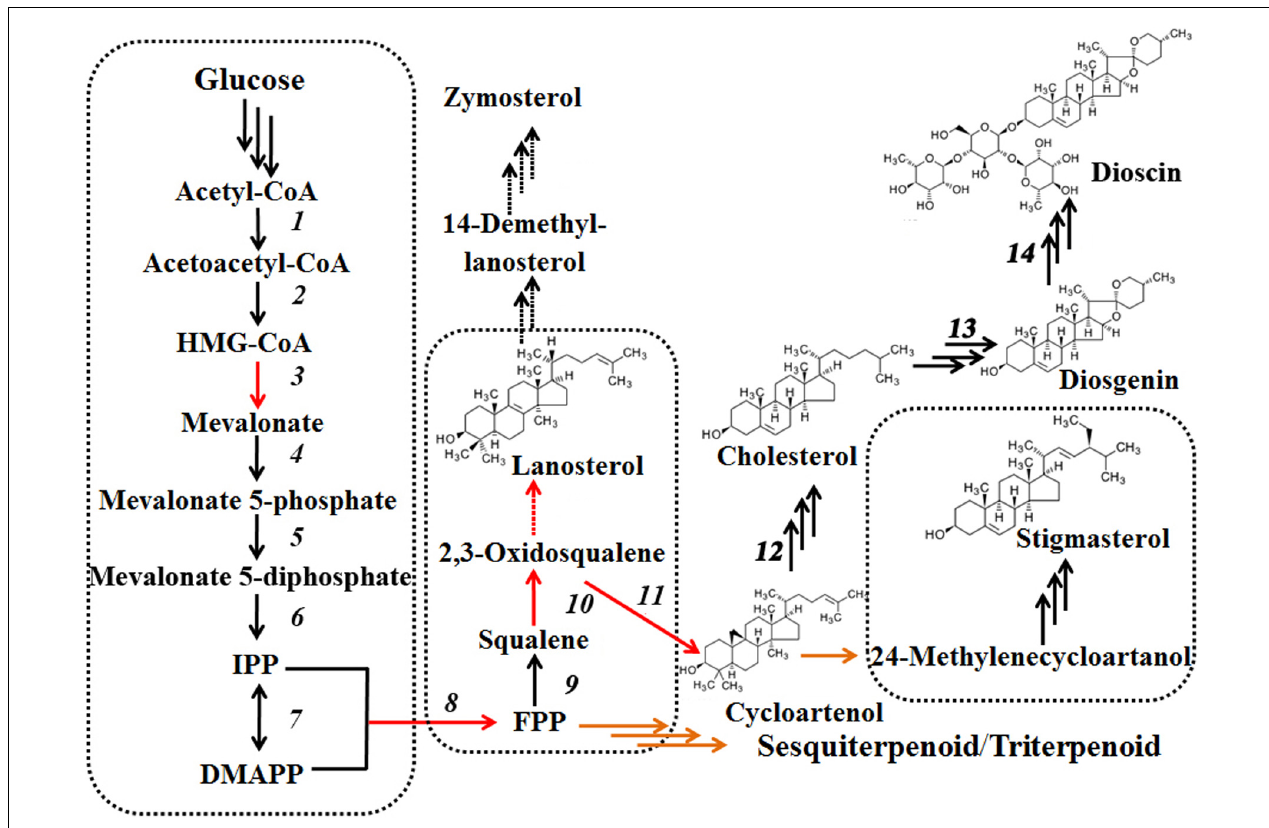
FIGURE 2 | Biosynthetic pathways of dioscin derived from cholesterol and plant C-24 alkylsterols. Plant C-24 alkylsterols and cholesterol, the common intermediates in dioscin biosynthesis, are biosynthesized from